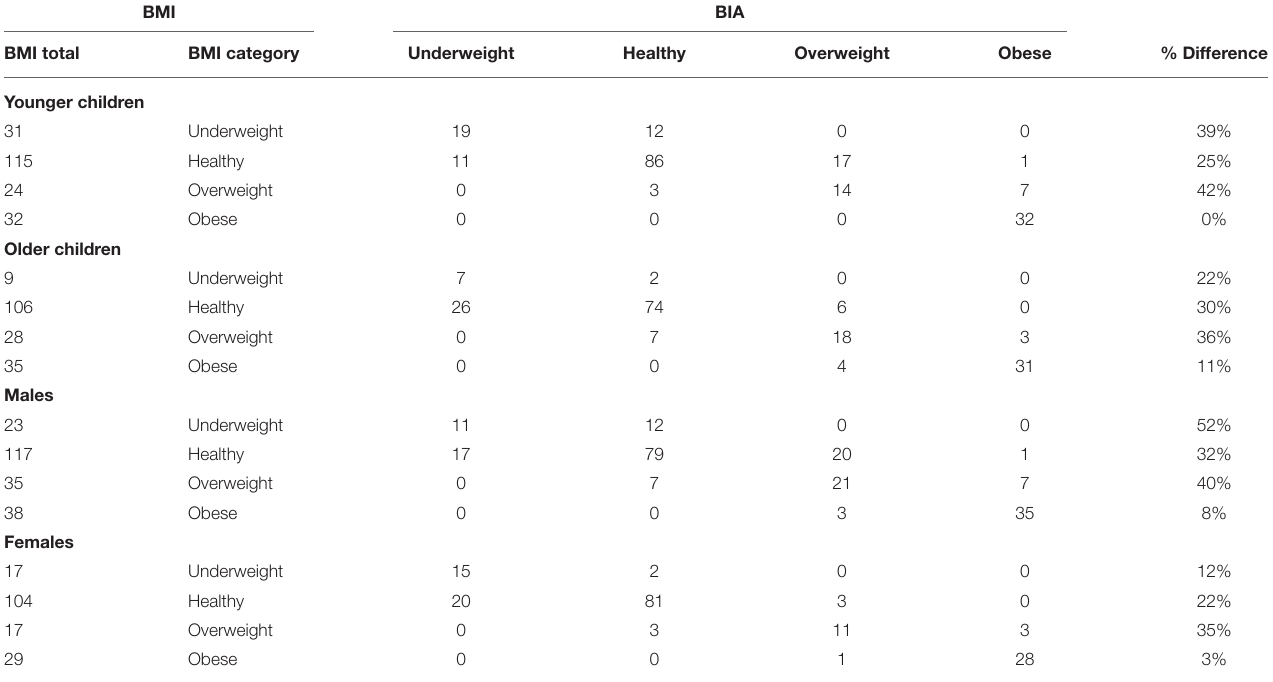
TABLE 4 | Classification differences between BMI and BIA by age and gender. BMI BIA